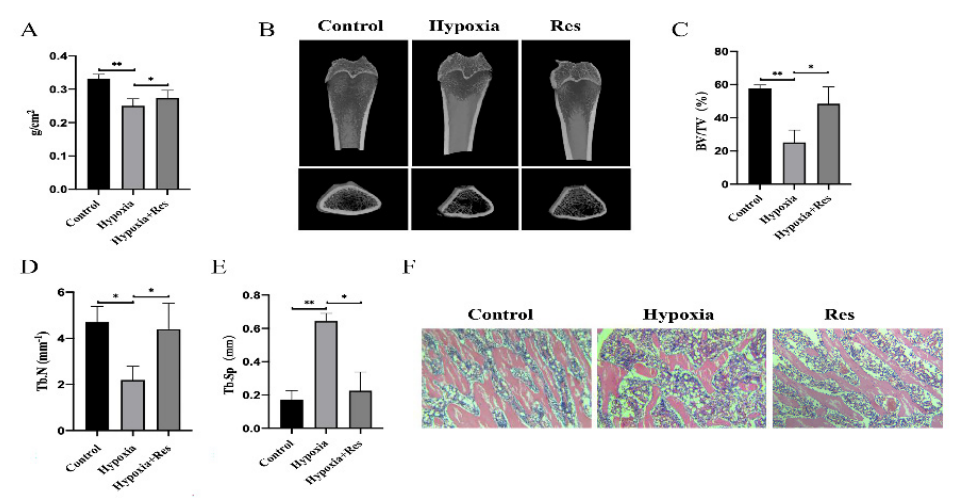
Figure 4. RES attenuated high-altitude hypoxia-induced osteoporosis in rats. ( A ) The BMD of rats from control group, hypoxia group and RES group. ( B ) Representative photograph of micro-CT reconstruction. ( C ) Bone volume per total volume (BV/TV). ( D ) Mean trabecular number (Tb.N). ( E ) Mean trabecular separation (Tb.Sp). ( F ) The results of HE staining of rats’ femurs from control group, hypoxia group and RES group. Values were expressed as mean ± SD. * p < 0.05, ** p < 0.01; all the assays were repeated more than three times.